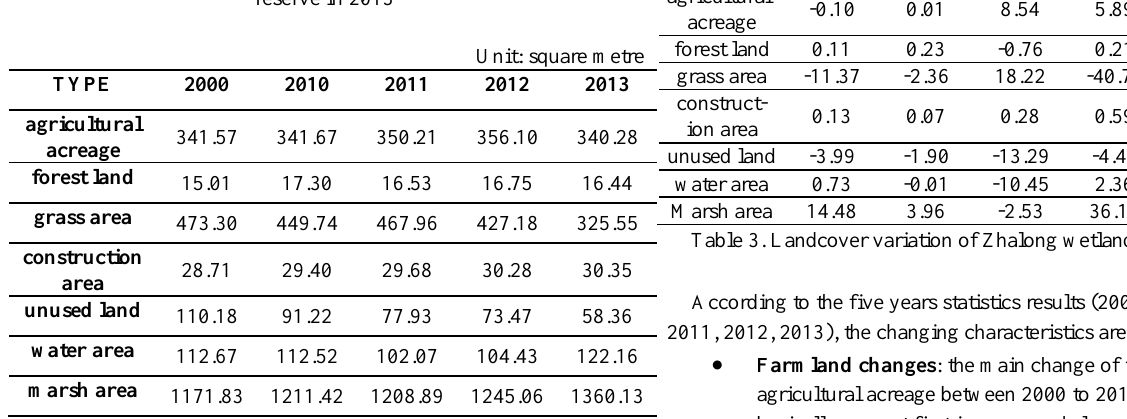
Table 2. Landcover structure table of Zhalong wetland reserve in 2013